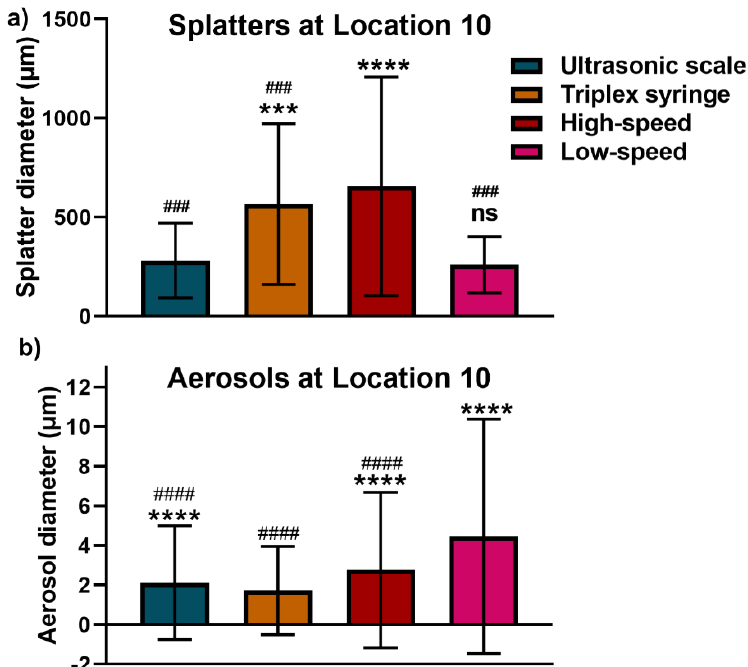
Figure 7. Average diameter of splatter ( a ) and aerosols/droplets ( b ) particles by four aerosol-generating procedures (AGPs) at location 10. ( a ) Different dental AGPs generated different splatter particles at a distance 120 cm away from the source. ns: no significant difference. ***: p < 0.0002 vs. ultrasonic scaler; ****: p < 0.0002 vs. ultrasonic scaler. ###: p < 0.0002 vs. high-speed handpiece. ( b ) Aerosol particles difference between different AGPs. ****: p < 0.0002 vs. triplex syringe. ###: p < 0.0002 vs. low-speed handpiece.